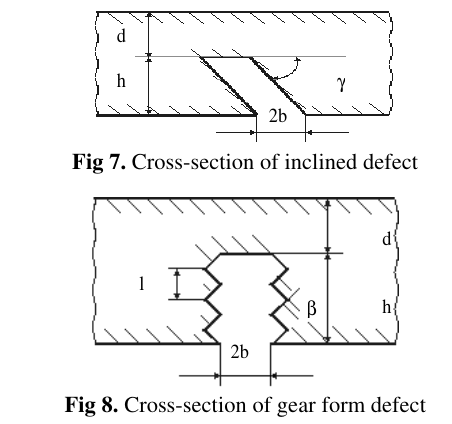
Fig 8. Cross-section of gear form defect